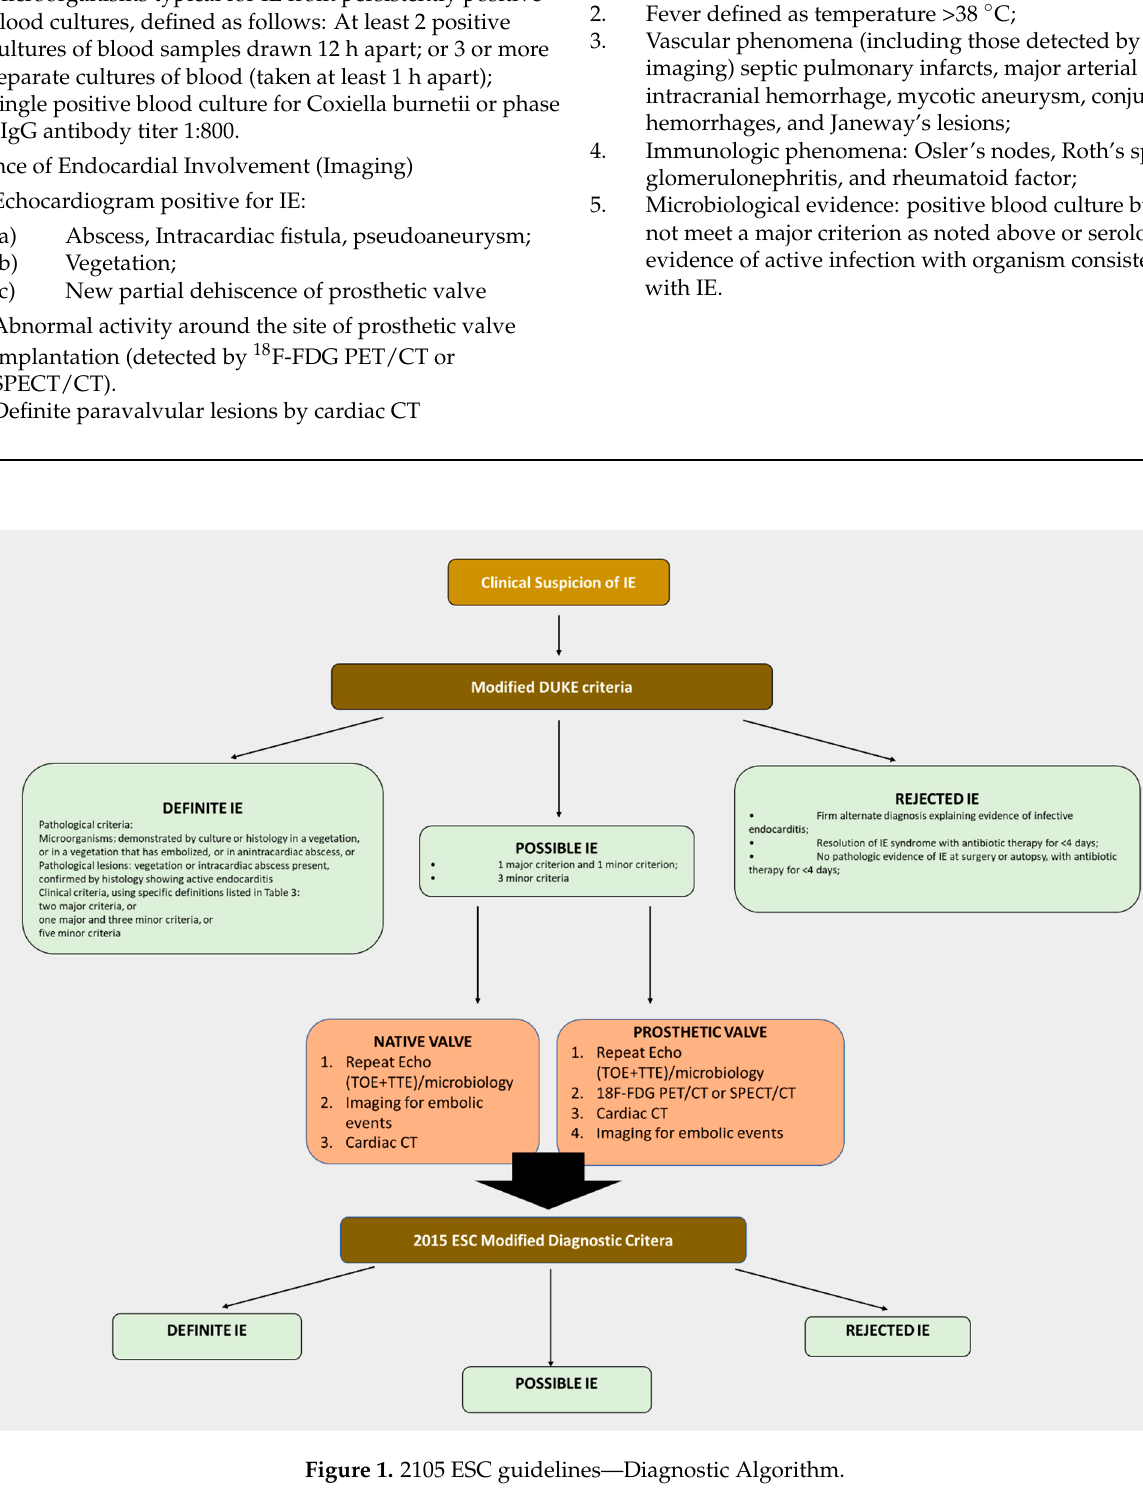
Table 1. Modified DUKE criteria for diagnosis of IE (in bold the modifications as per 2015 ESC guidelines).